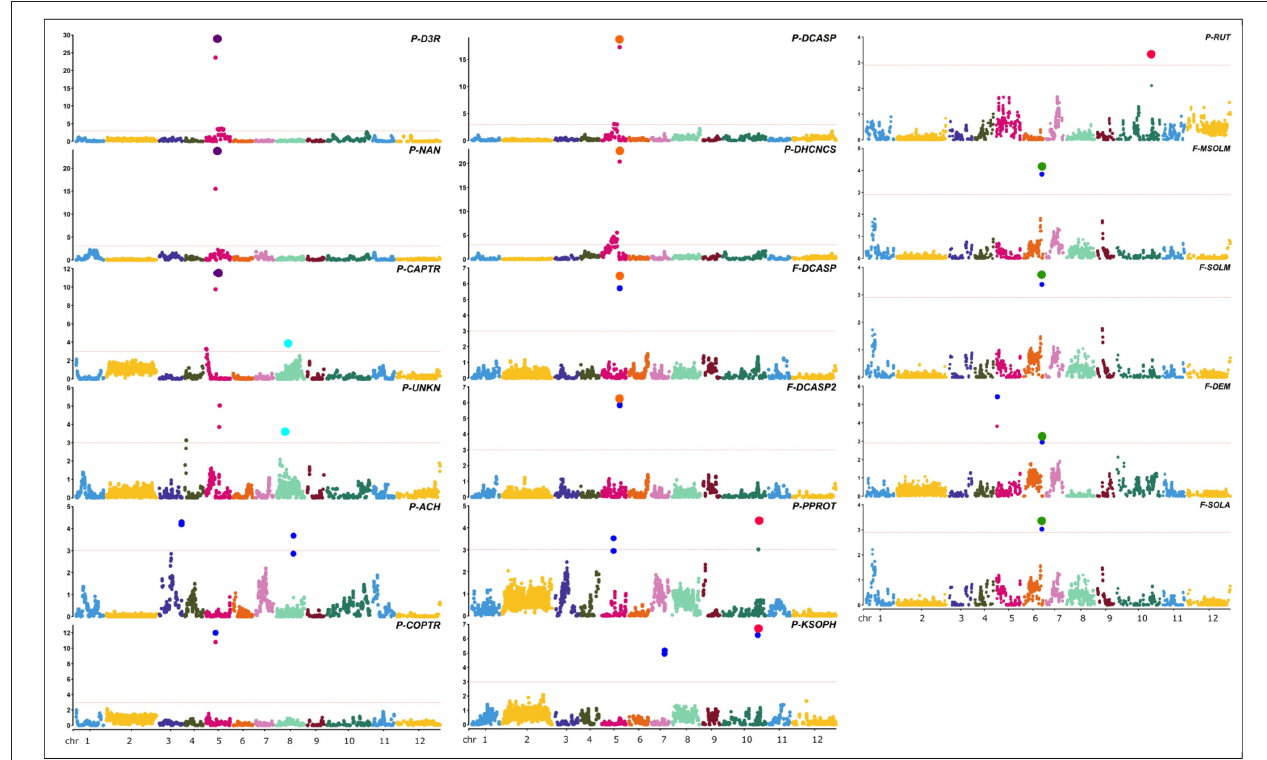
FIGURE 7 | Positions of QTLs identified for the metabolites in study. Red lines in the Manhattan plots indicate LOD significance threshold. Blue dots represent significant markers within the confidence interval of the QTL (LODmax-1 interval), with LOD values plotted against genome locations. Cluster of QTLs are indicated as purple (P - FLAVO/POLY 5), orange (F/P - POLY 5), green (F-GLYKO 6), light blue (P-POLY/ ACTPH 8), and red (P-FLAVO/GLYKO 10) dots.